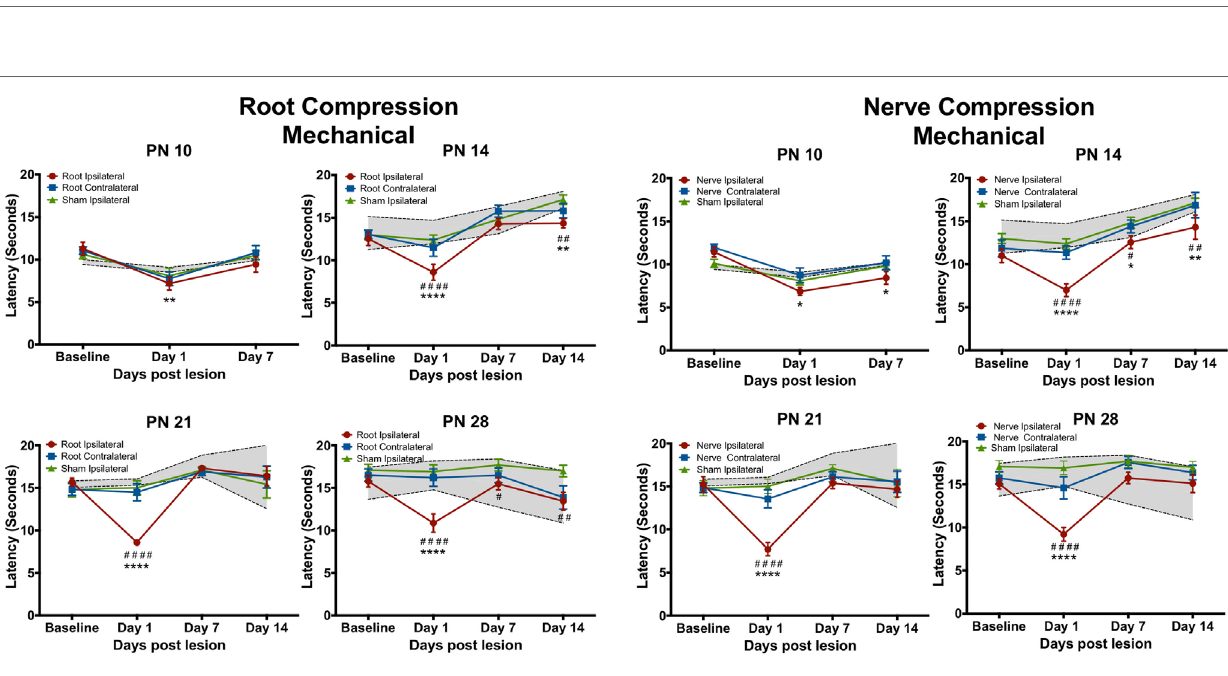
FigUre 3 | The change in the forepaw response to the mechanical stimulus following root or nerve compression . Details are as in Figure 2 . N = 8 for PN10 and PN28; N = 6 for PN14 and PN21.